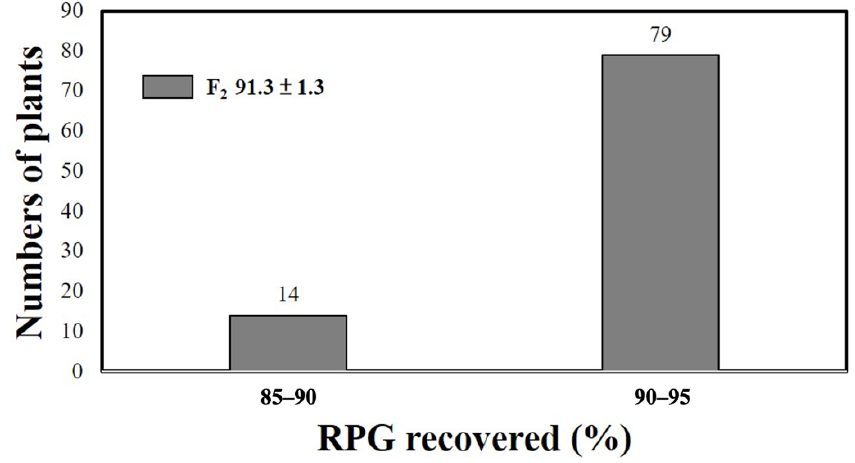
Figure 4. Frequency distribution of the recurrent parent genome (RPG) recovery rate estimated by markers in the F 2 generation of the purple functional rice population.